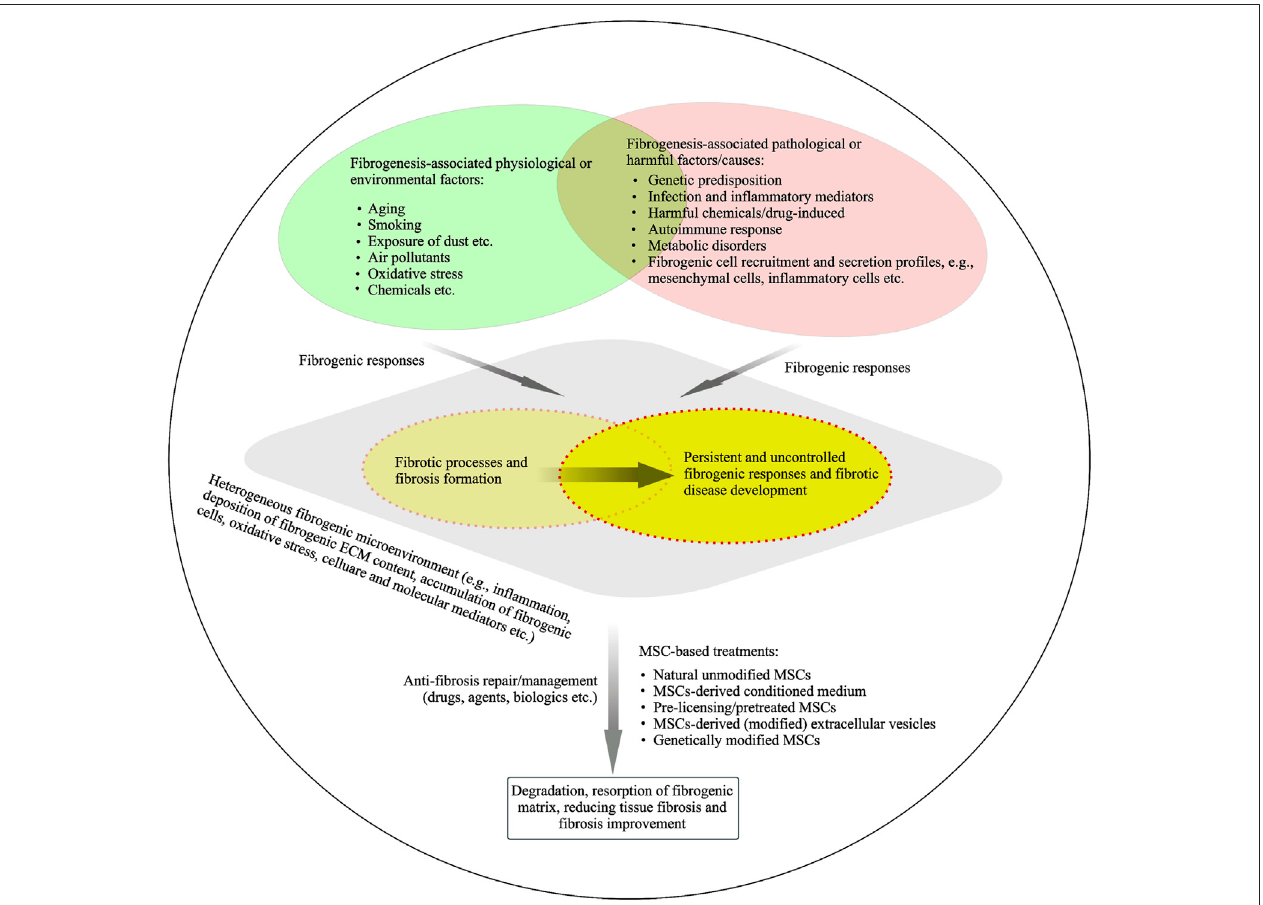
FIGURE 3 | Fibrogenic process and fi brosis resolution under heterogeneous fi brogenic conditions. A hypothetical model of a temporary heterogeneous (pathophysiological) microenvironment is suggested for the understanding of fi brosis physiological or pathological responses. Potential physiological or pathological factors are linked to fi brosis and fi brotic development. MSCs or MSCs derived products are being developed in preclinical and clinical studies to understand their potential anti- fi brotic properties.